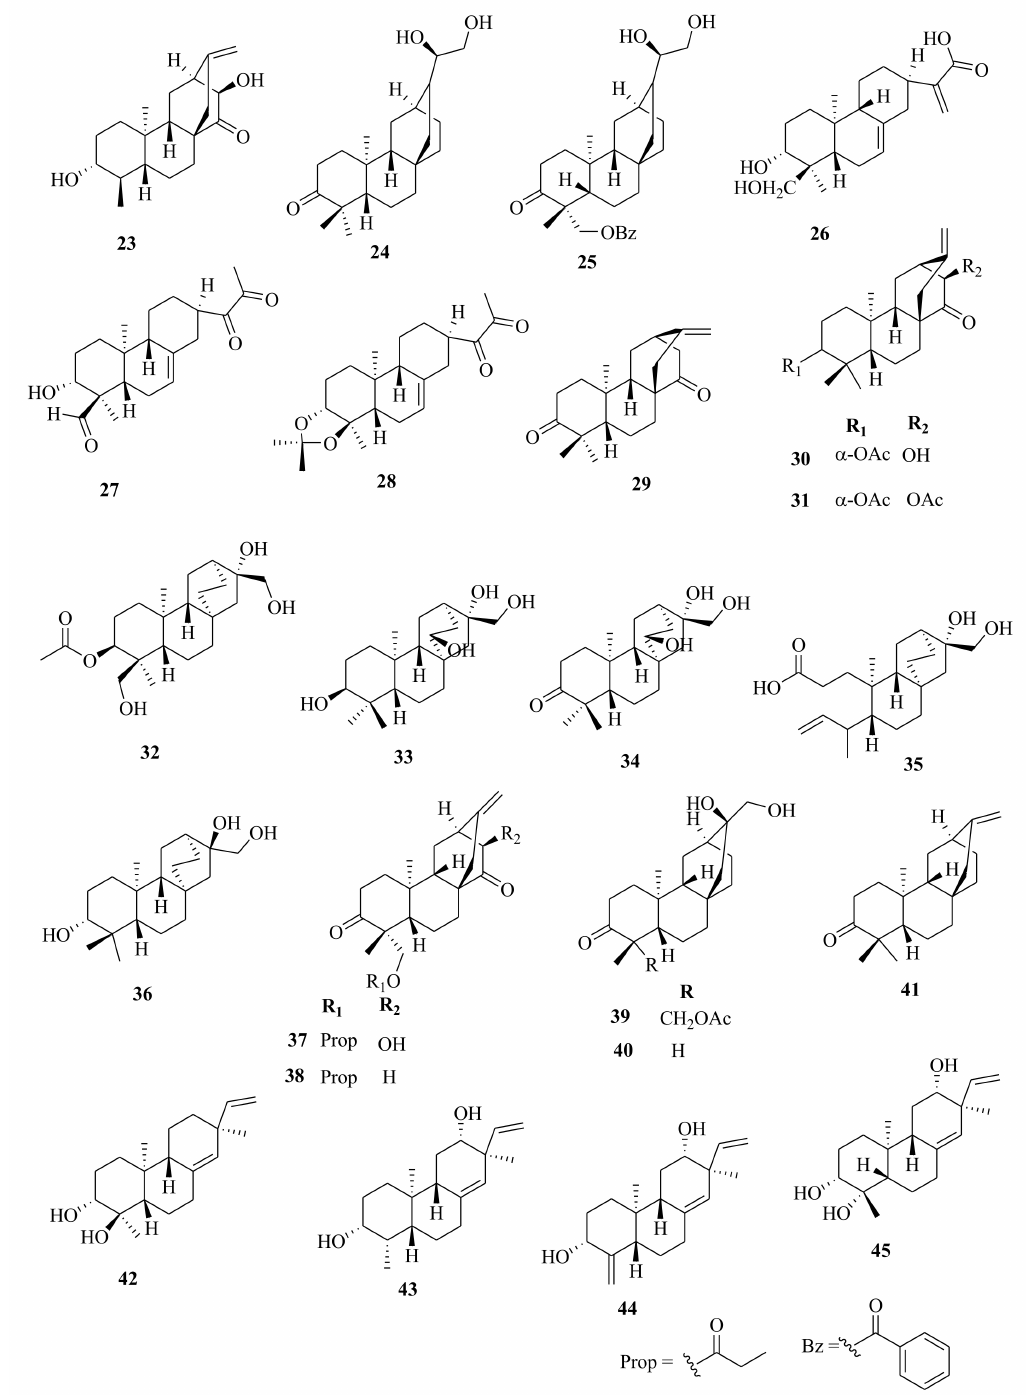
Figure 2. Chemical structures of cembrane and abietane